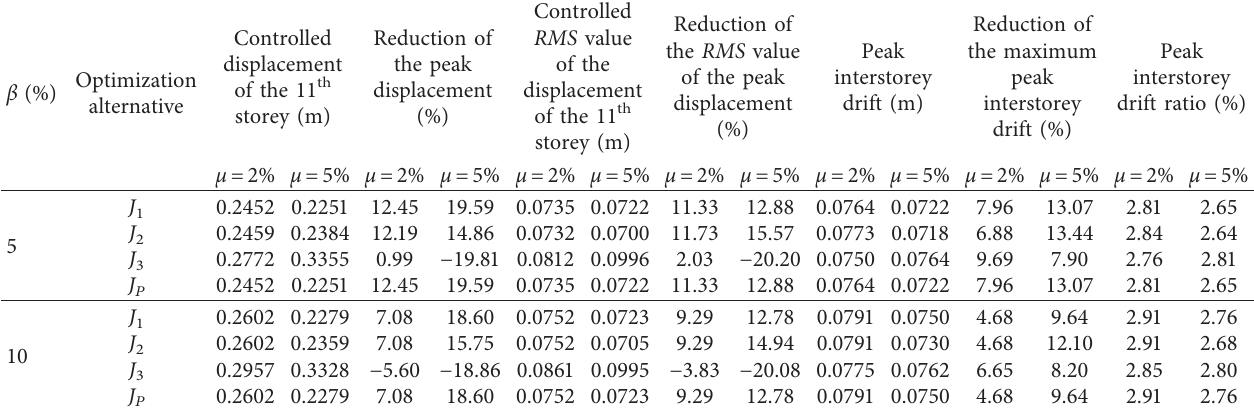
Figure 12: RMS value of the acceleration of each storey of the controlled structure subjected to “ Kobe ” acceleration record for TMDI designed with µ � 5% and the J P optimization alternative. Table 14: Controlled response of the structure subjected to “ Algarrobo ”